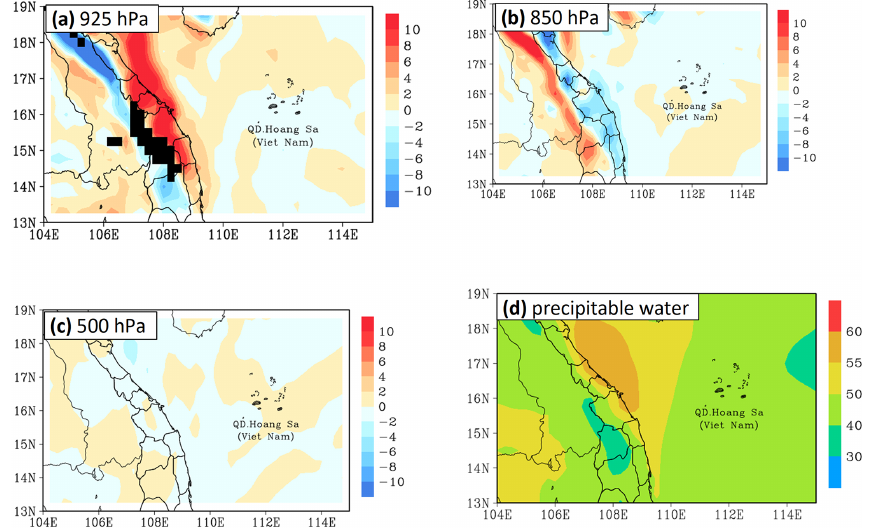
Figure 7. (a) The ERA5 averaged moisture convergence/divergence ( × 10 − 4 , gkg − 1 s − 1 , shaded, positive for convergence) at the 925hPa, from 00:00UTC on 8 December to 18:00UTC on 11 December 2018. The black areas are where the 925hPa level is below the ground. (b) As in panel (a) , but for the 850hPa. (c) As in panel (a) , but for the 500hPa. (d) The ERA5 averaged precipitable water between surface and 200hPa (mm), from 00:00UTC on 8 December to 18:00UTC on 11 December 2018.